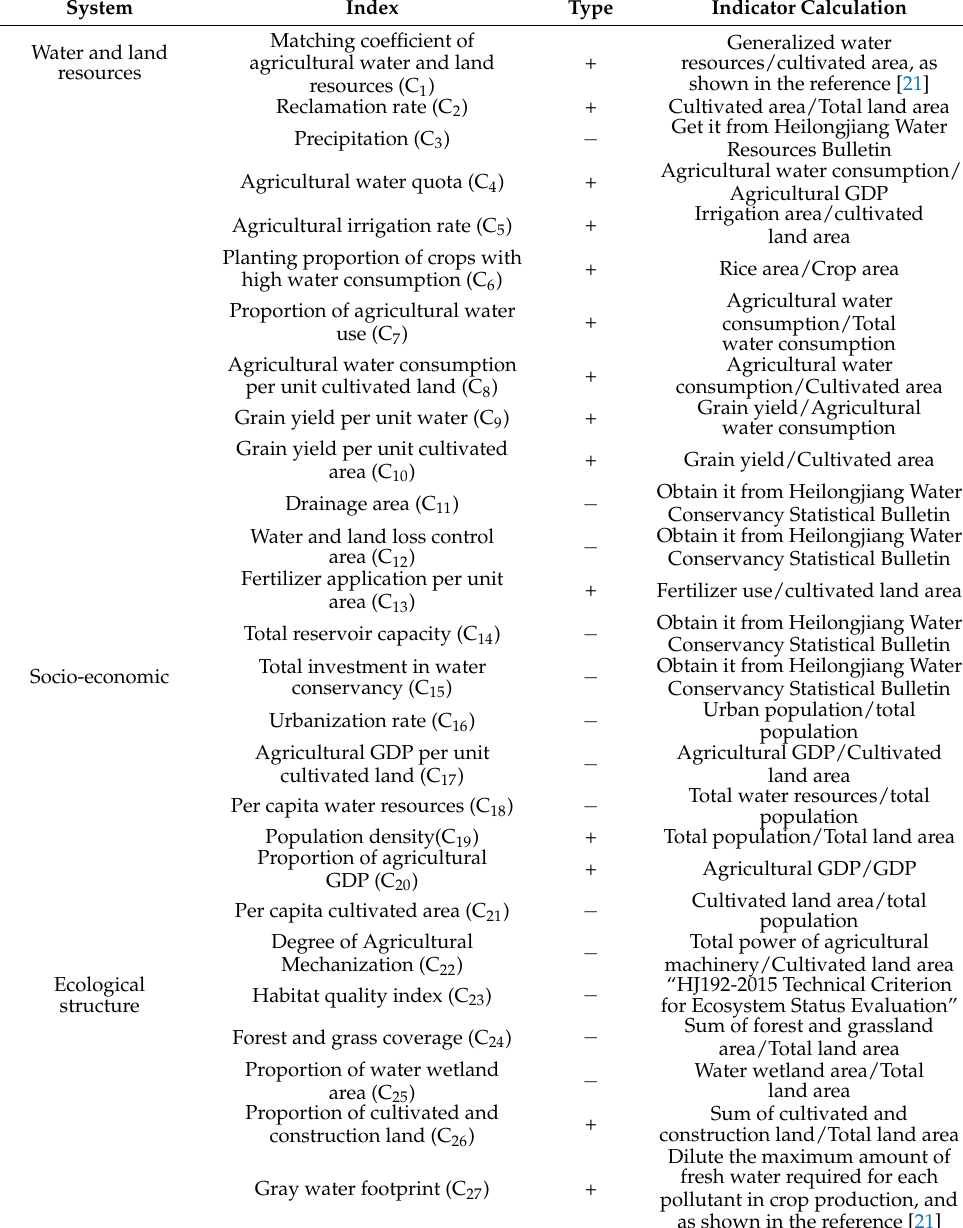
Table 1. AWLRSV evaluation index